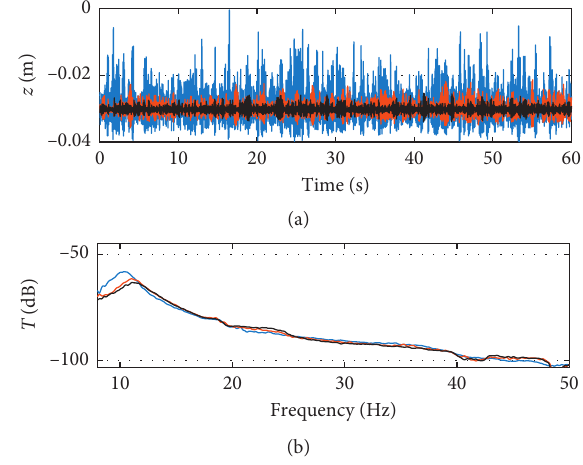
Figure 7: Random tests. Black line: € b � 7m/s 2 RMS; orange line: € b � 9 m/s 2 RMS; blue line: € b � 26 m/s 2 RMS. (a) Time history of the displacement (first 60 seconds); (b) transmissibility T